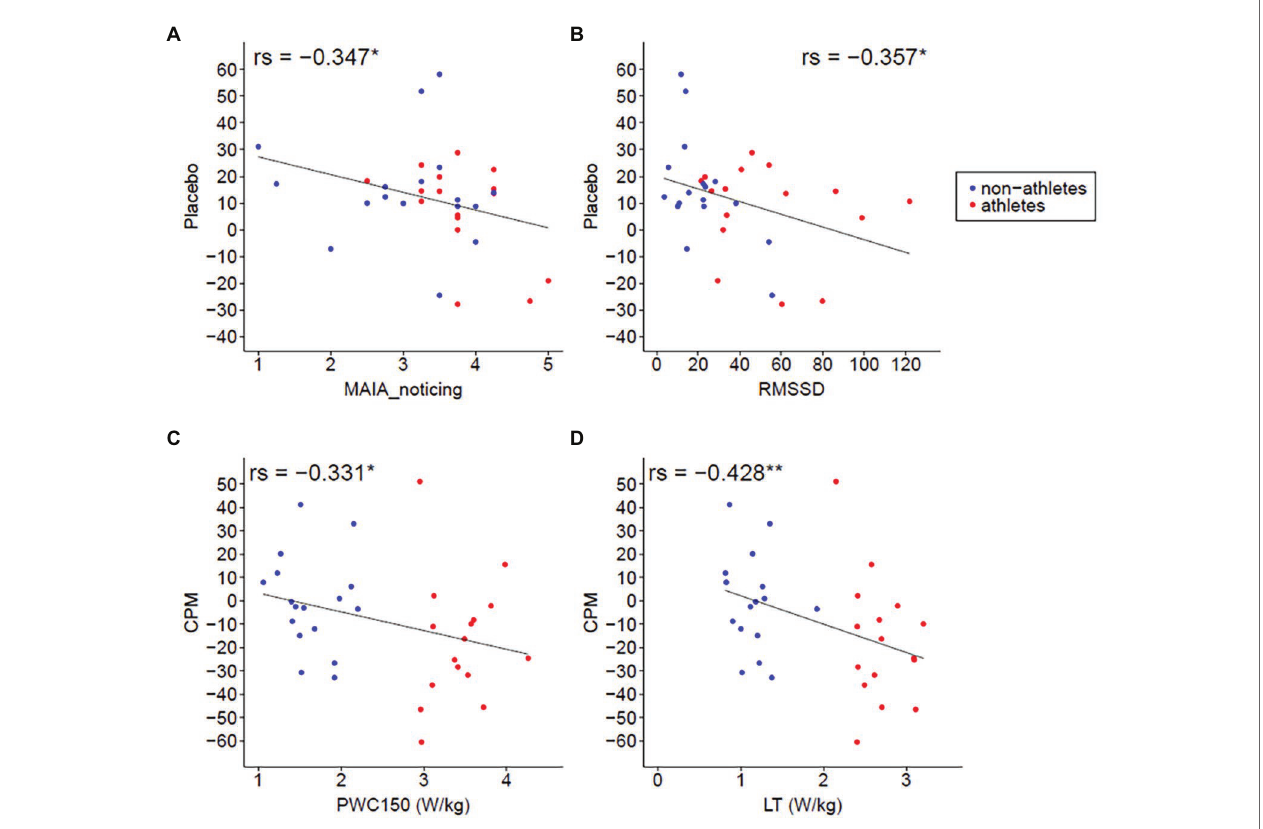
FIGURE 7 | Association analyses. (A) Correlation of interoceptive awareness [multidimensional assessment of interoceptive awareness (MAIA)] and placebo. The higher the interoceptive awareness rating, the less strong the placebo effect [ r s(31) = − 0.347, p = 0.048]. (B) Correlation of HR variability (RMSSD) and placebo. The higher the HR variability, the less strong the placebo effect [ r s(31) = − 0.357, p = 0.042]. (C) Correlation of PWC150 and CPM. The higher the PWC, the stronger the CPM effect [ r s(32) = − 0.331, p = 0.030, one-tailed]. (D) Correlation of lactate threshold (LT) and CPM. The higher the LT, the higher the CPM effect [ r s(31) = − 0.428, p = 0.008, one-tailed; 1 missing LT